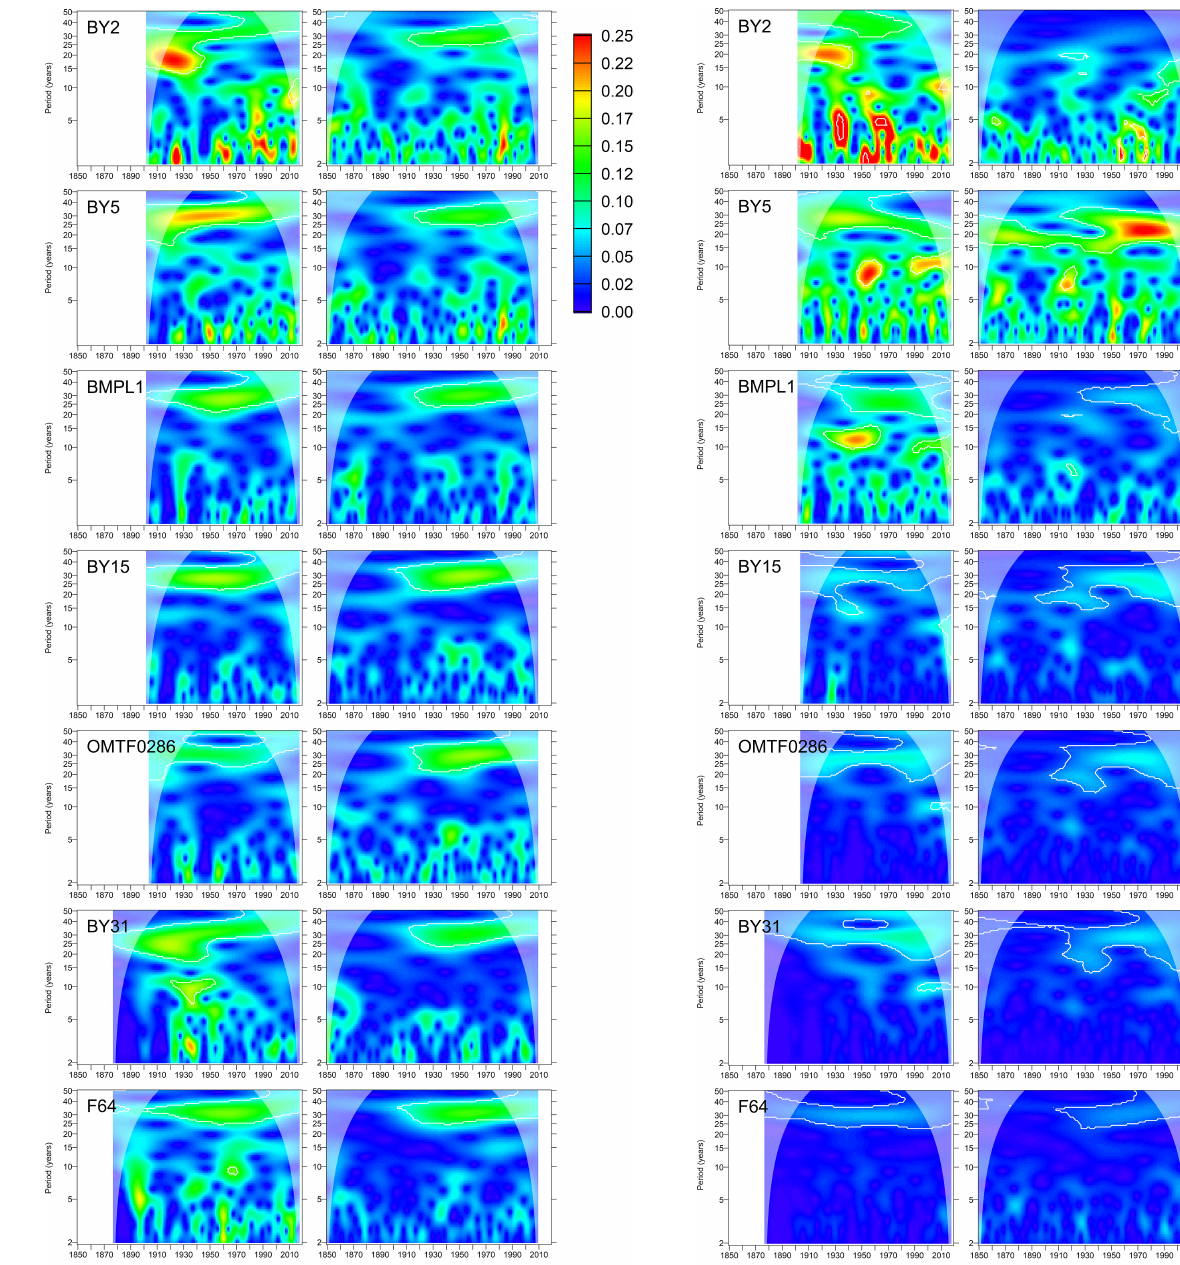
Figure 7. Wavelet amplitudes of bottom salinities at selected oceanographic stations (g kg − 1 ). Left column: observations; right column: model results. White contours denote significant ampli- tudes at the 95% confidence level compared to surrogate data ran- domized by shuffling the